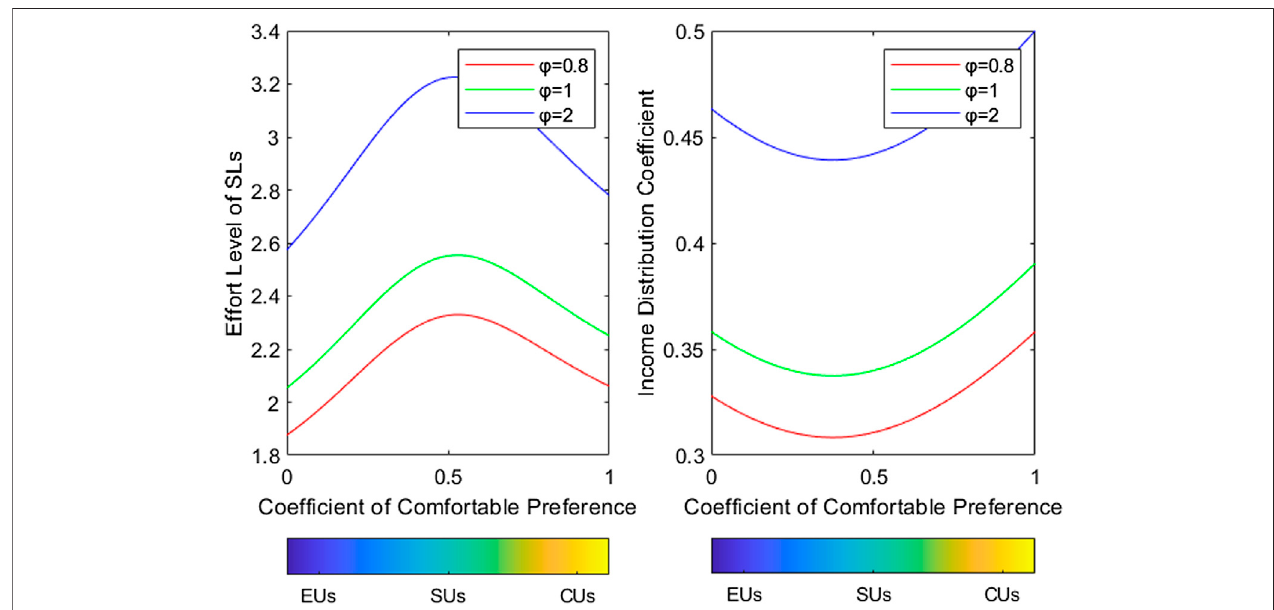
FIGURE 7 | Relationship between effort level/pro fi t distribution coef fi cient and SLs ’ type under different risk preferences.